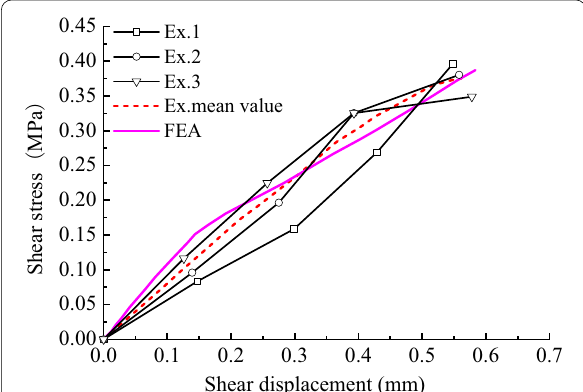
0.0 Fig. 18 Comparison between experimental and numerical shear stress–shear displacement response of wood normal contact